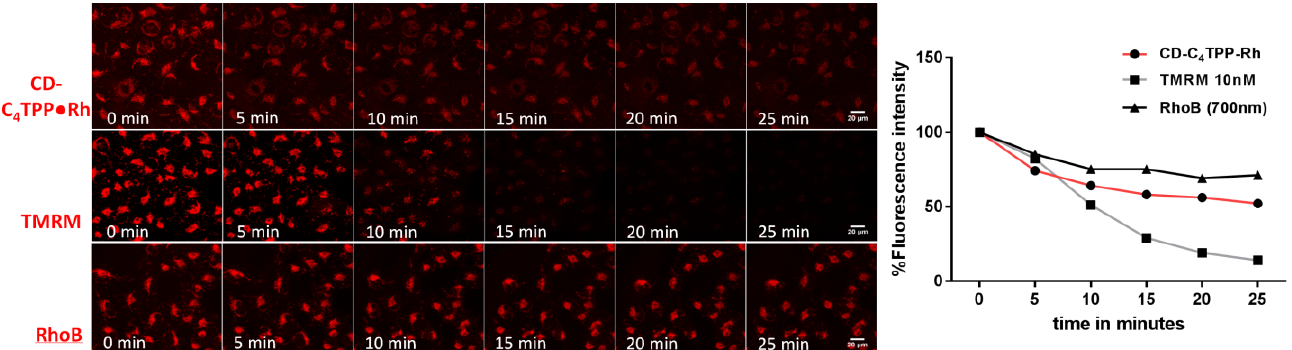
Figure 6. Photostability of CD-C4TPP•Rh vs. TMRM and RhoB in live MDA-MB-231 cells and the corresponding fluorescence quantification (%) over time. Cells were treated with 50 μ g/mL CD-C4TPP•Rh for 3 h, and TMRM 10 nM or RhoB 700 nM for 30 min. Photostability was assessed under continuous laser irradiation with 5 min intervals. Scale bar: 20 μ m.